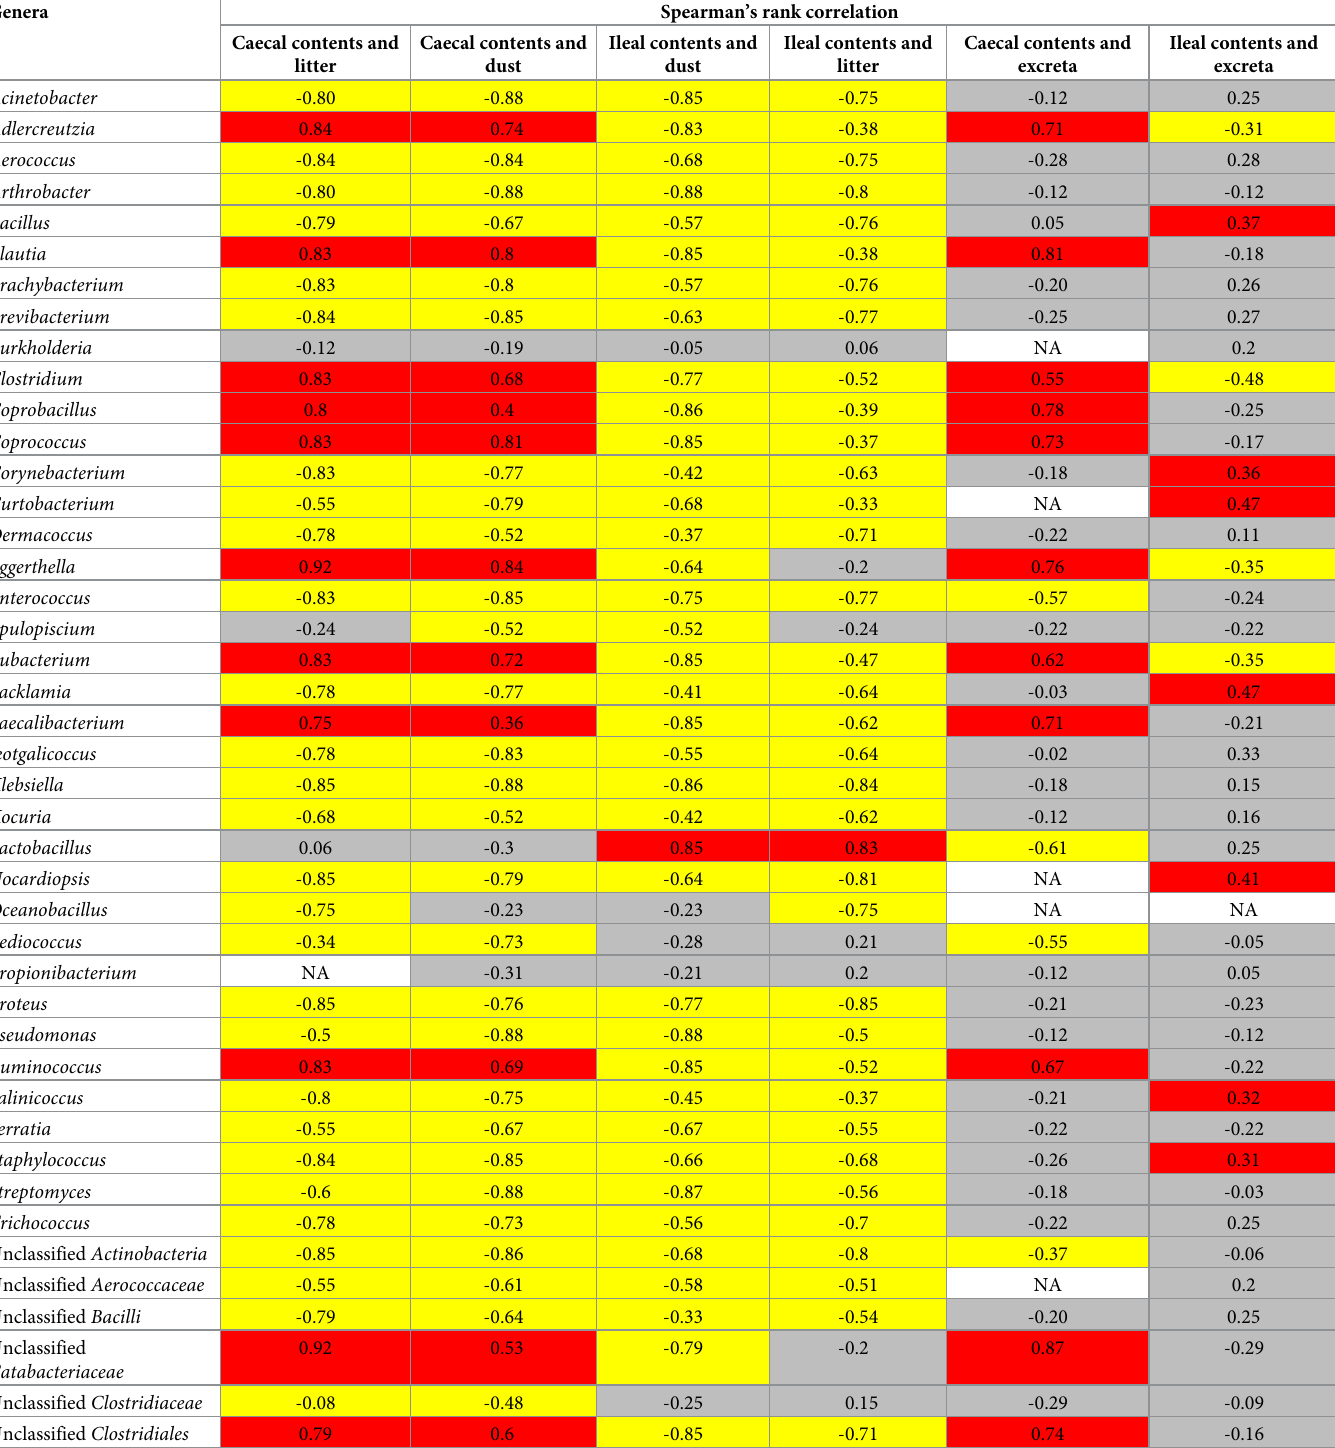
Table 2. Spearman’s rank correlation between the relative abundance of genera of non-invasive samples (dust, excreta and litter) and invasive samples (ileal and caecal contents).